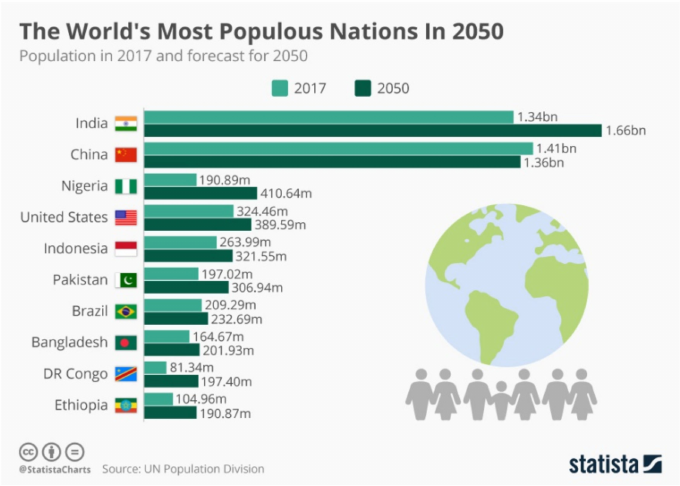
Figure 1. World population estimates for 2050